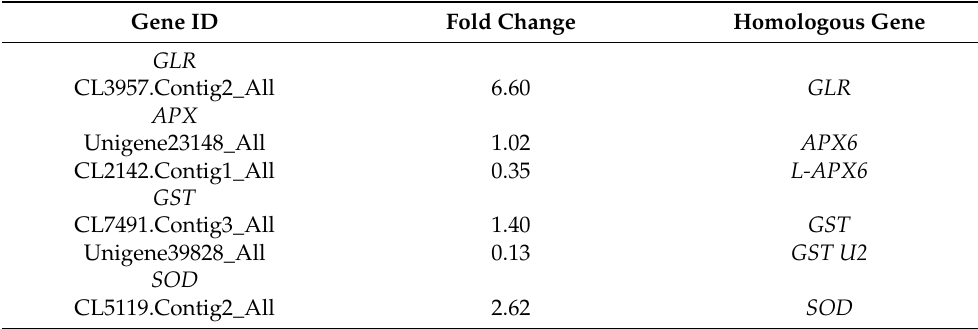
Table 4. The upregulated DEGs related to the ROS scavenging system in the roots of A. canescens under 100 mM NaCl, but not under the control conditions, for 6